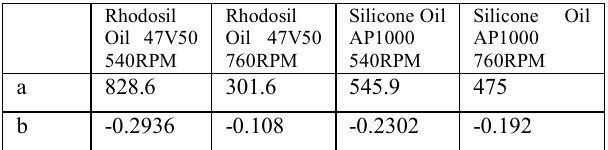
Table 1. Coefficients a and b for the interleaved time- dependent curve MPD